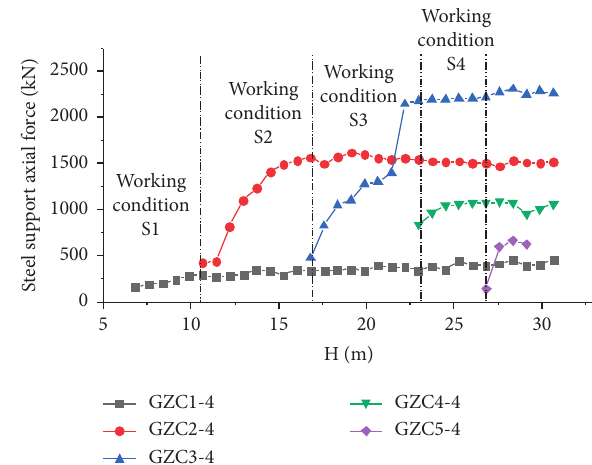
Figure 18: The relationship between the maximum vertical de- formation of the ground surface and the maximum lateral de- formation of the ground connecting